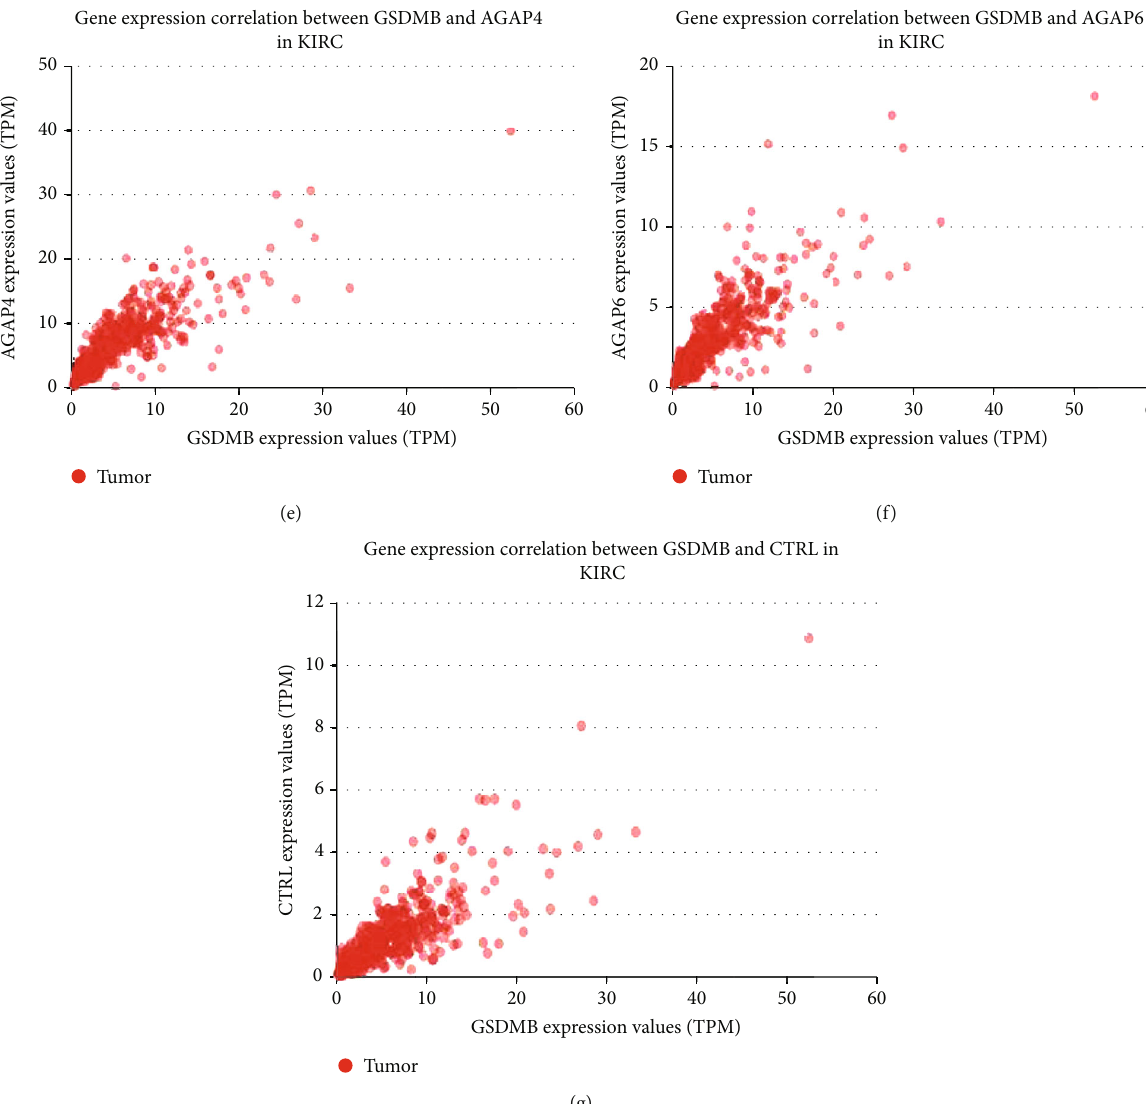
Figure 7: PPI networks and functional enrichment analyses. (a) A network of GSDMB and its coexpression genes. (b) Functional enrichment analyses of 10 involved genes. GSDMB was associated with cytokine-cytokine receptor interaction. (c – g) The correlation analyses between the expressions of GSDMB and coexpressed genes in ccRCC. ccRCC: clear cell renal cell